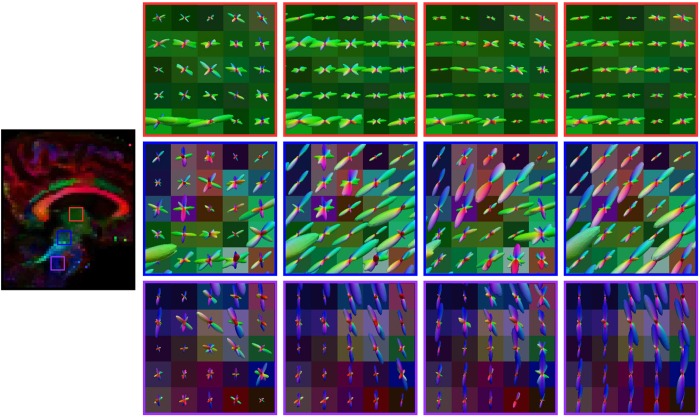
Sagittal view of ODFs.Similar to Fig. 6, but in sagittal view.